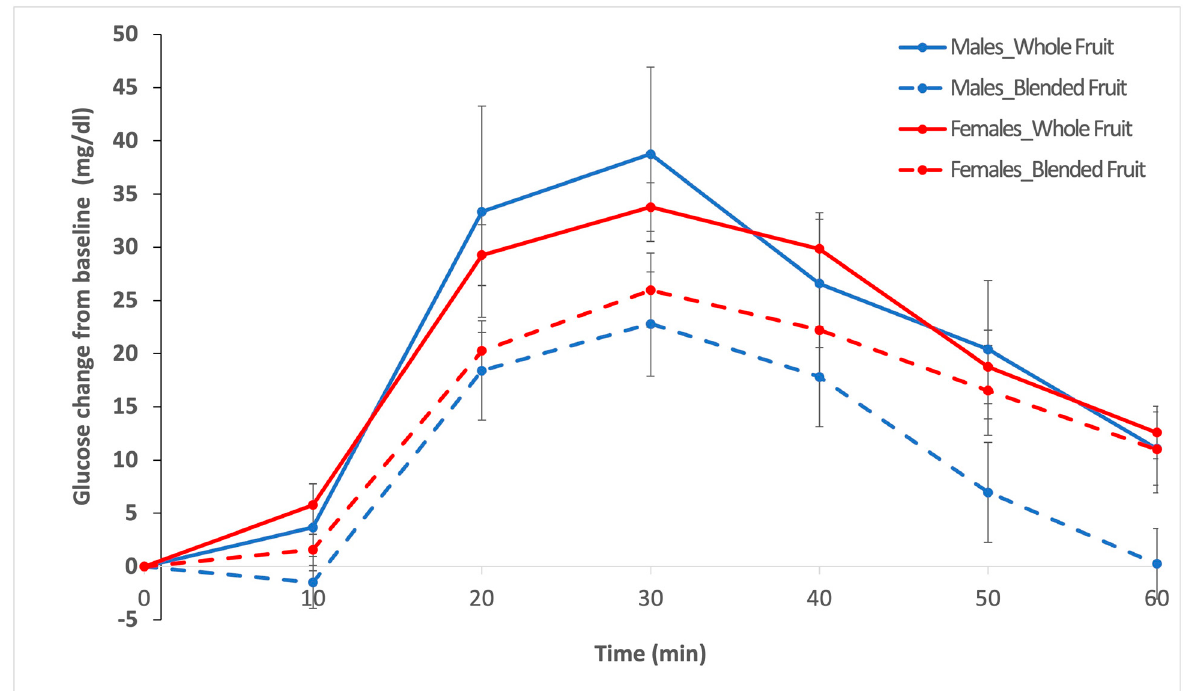
Figure 3. Mean incremental blood glucose values subtracted from baseline blood glucose values in males ( n = 8; blue lines) and females ( n = 12; red lines) over 60 min, after consuming either whole fruit (solid lines) or blended fruit (broken lines). Error bars represent SEM.